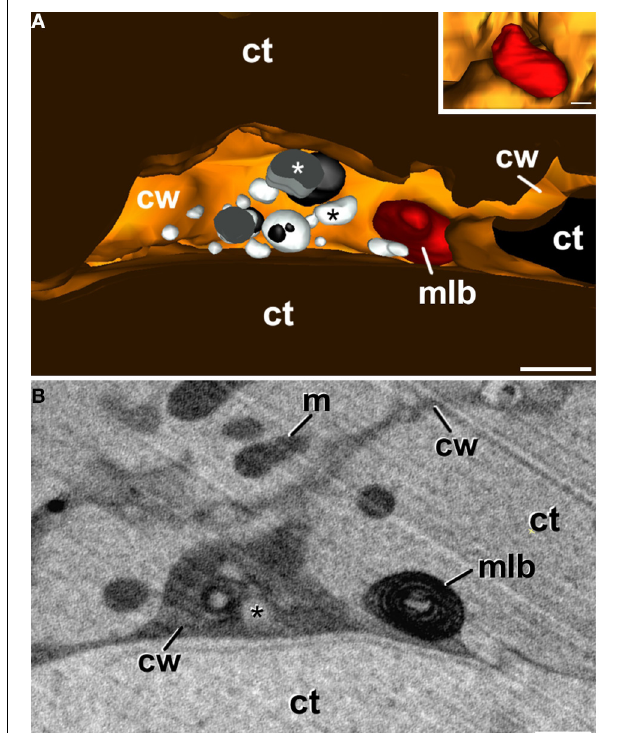
FIGURE 5 | 3-D reconstruction of a region from a newly-formed cell wall of a B. napus embryogenic microspore. (A) is a 3-D model showing the apoplast with several vesicular bodies of different electron density (white and black asterisks), and an excreted plastid, degraded to become a multilamellar body (mlb). The inset shows the plastid from a different perspective. Note that part of the plastid is tightly surrounded by the plasma membrane whereas the other part is facing the apoplast. (B) One of the FESEM-FIB micrographs used for the 3-D reconstruction showing the multilamellar body separated from the excreted cytoplasmic vesicular bodies (asterisk), embedded in a matrix of dense material. ct, cytoplasm; cw, cell wall; m, mitochondrion. Bars: